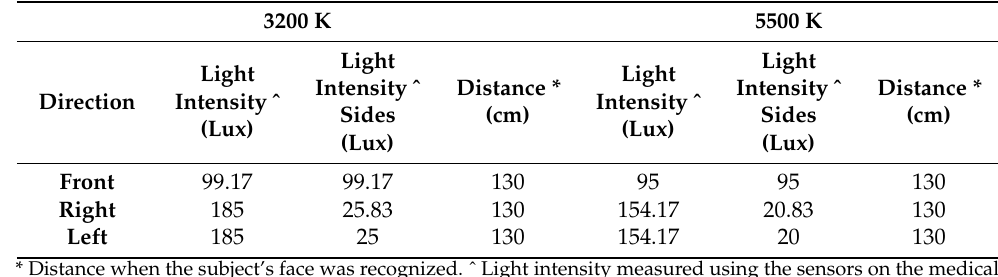
Table 7. Comparison results between the light intensity (Lux) and light color (Kelvin) for a fixed distance of detection of 130 cm for light source without diffuser from front, right, and left side.